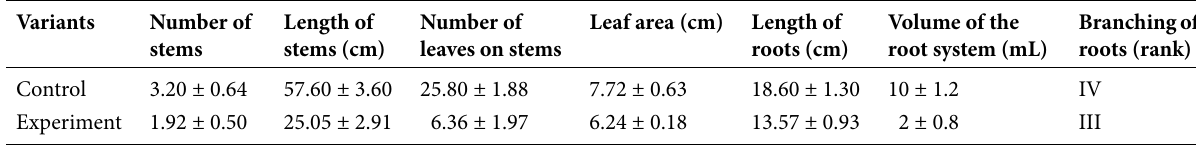
Table 4 Effect of salinity on morphometric parameters of Salix viminalis under field conditions at Stebnyk tailing, 120 days of